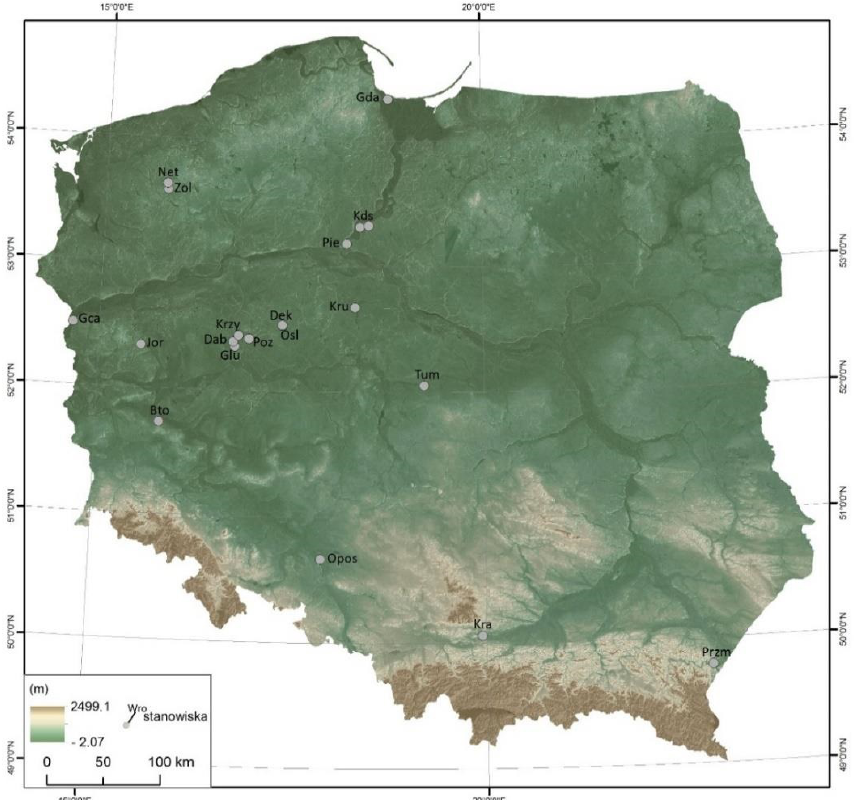
Figure 3. Sites with finds of horse skeletons (the acronym of the position is given in the first place, the number or name of the site in the following place, the category of the site and the number of skulls in brackets): Bto —Bytom Odrzański, 1 (stronghold— 2); Dab —Dąbrówka, 2 (stronghold— 2);